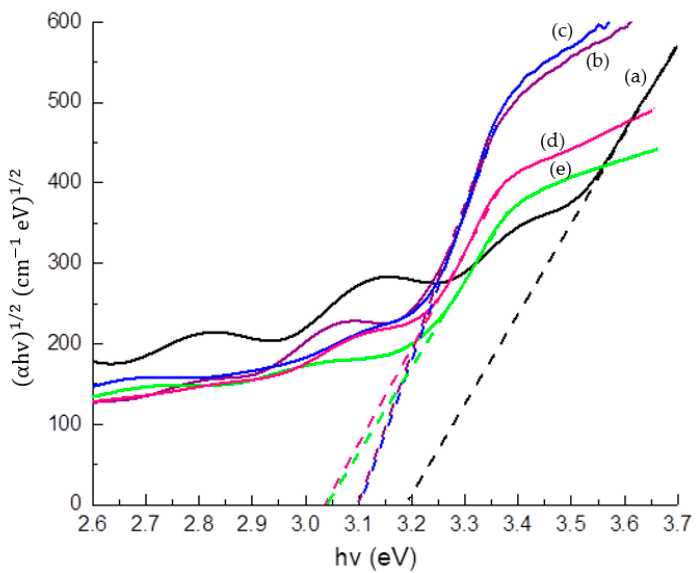
Figure 7. Extrapolated band gap of ( a ) the n-TiO 2 /FTO substrate and the n-TiO 2 /ZnO bilayer thin films annealed for ( b ) 1, ( c ) 1.5, ( d ) 2, and ( e ) 2.5 h at 500 °C, respectively.